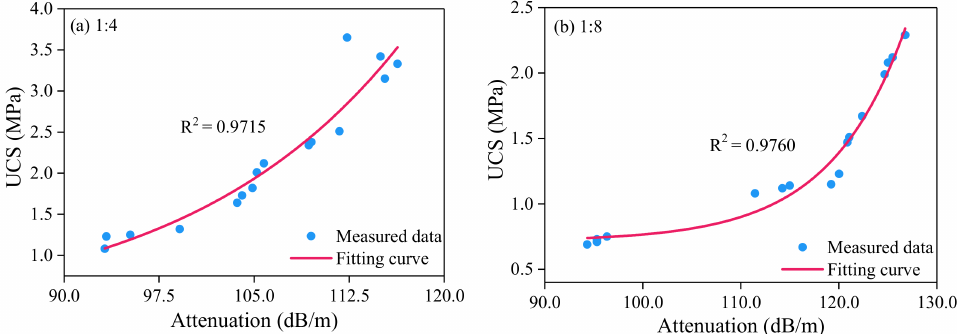
Figure 10. Relationship between UCS and attenuation data for different cement-tailings ratio. Quan- tification of UCS by wave